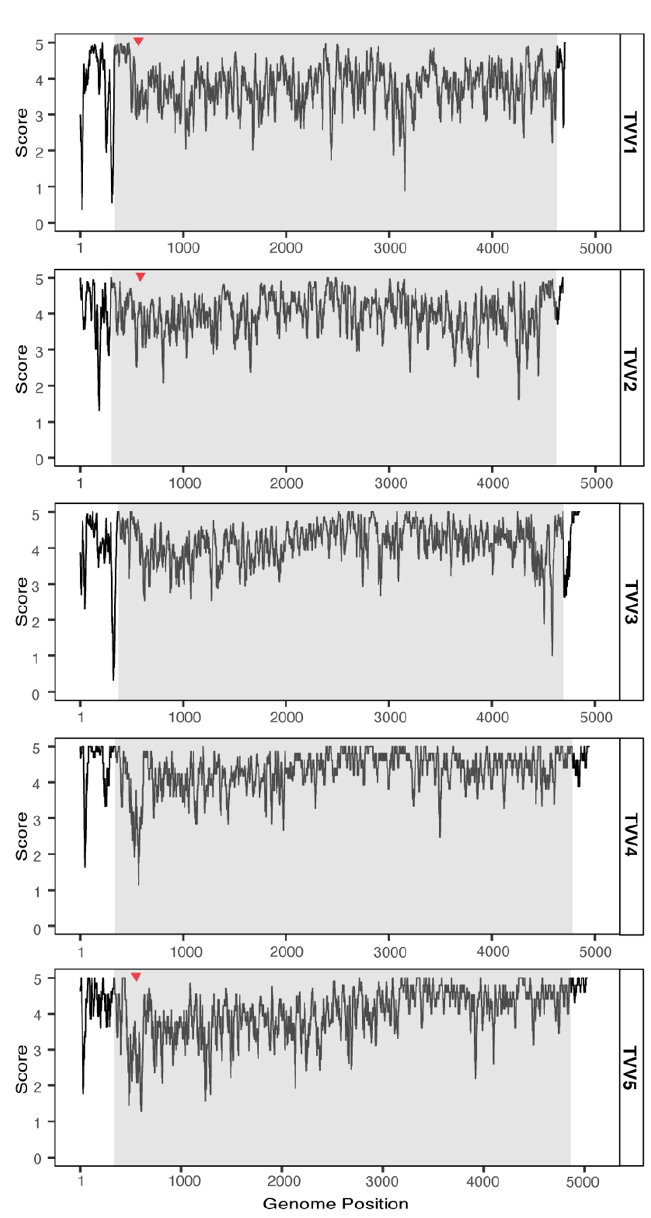
Figure 3. Conservation plots for nt sequences of TVV1 through TVV5 strains. For each trichomonasvirus species, complete and partial coding sequences were retrieved from NCBI GenBank and combined with new assemblies that were coding-complete or nearly so. A sliding window of 15 nt was chosen for smoothing. The EDNAFULL substitution matrix was used, in which a score of 5 denotes perfect identity at a given position. Gray boxes denote the CDS for the CP/RdRp of each species. Red triangles denote positions of any indels within the CDS (also see Figure 2).